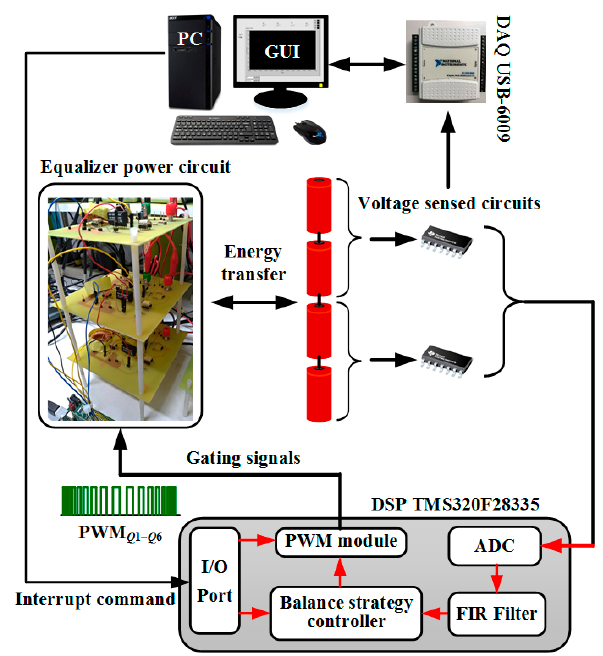
Figure 6. Schematic configuration of the proposed equalizer system applied to a four-cell string case.